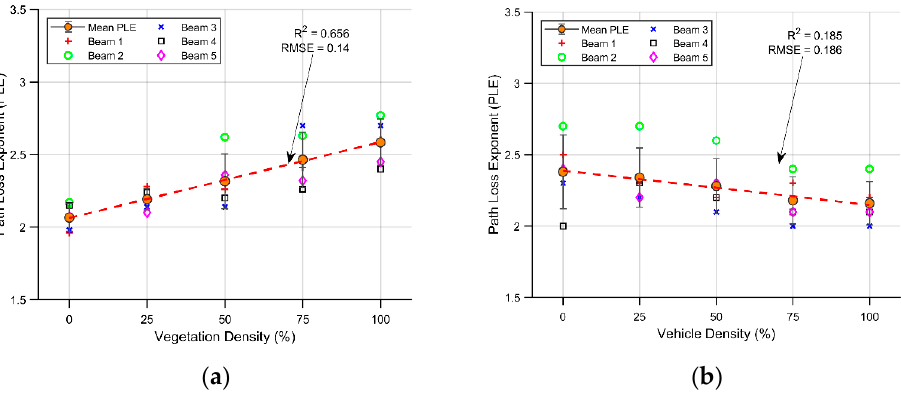
Figure 8. Density effects on the PLE: ( a ) different vegetation densities; ( b ) different vehicle densities.